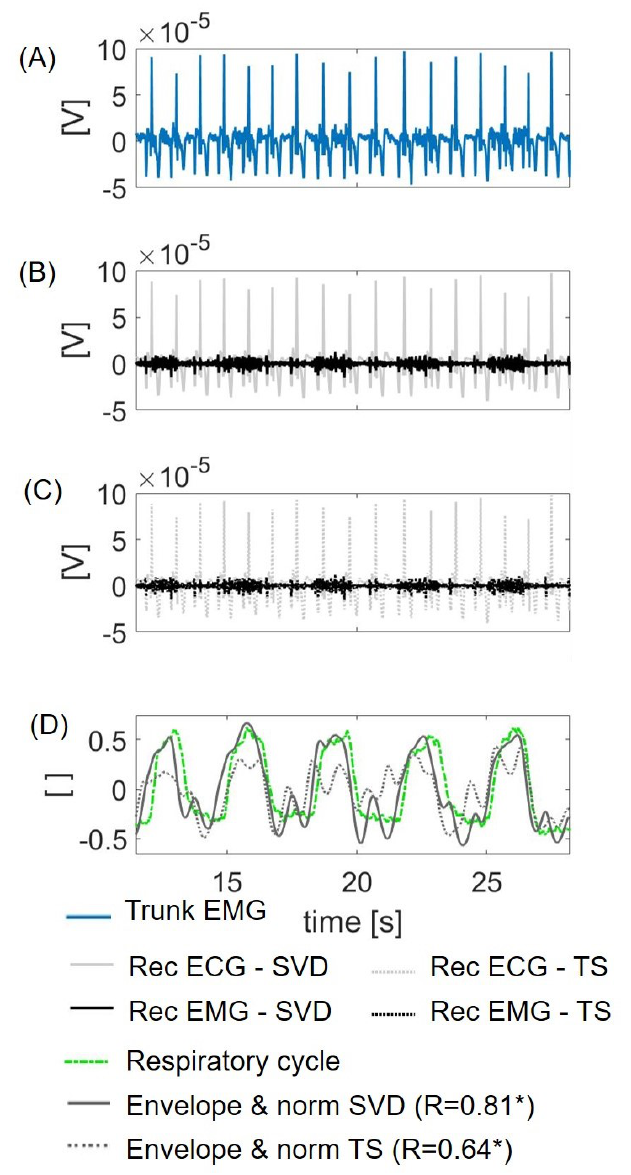
Figure 8. Illustrative results of the signal obtained with the algorithm applied on a real signal from trunk EMG (diaphragm). ( A ) Trunk EMG; ( B ) reconstructed ECG (Rec ECG in red) and EMG (Rec EMG in black) with the SVD-based algorithm; ( C ) reconstructed ECG (Rec ECG in dotted red) and EMG (Rec EMG in dotted black) with TS; ( D ) the envelope of the Rec EMG was computed and normalized with its maximum (gray line for the SVD-based algorithm and dotted gray line for TS). The inverted esophageal pressure is also shown (green line) as a reference of the respiratory cycle. R: correlation coefficient between EMG and esophageal pressure, * if p -value <